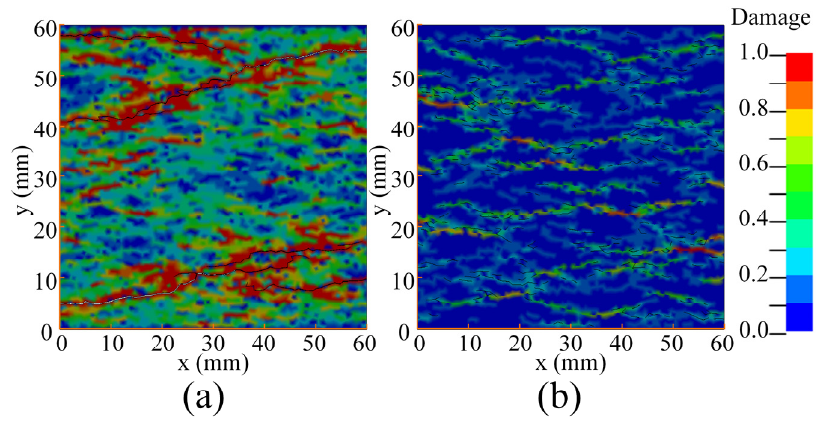
Figure 9. Damage of specimen: ( a ) result of DIF G = 1; ( b ) result of DIF G = DIF T .